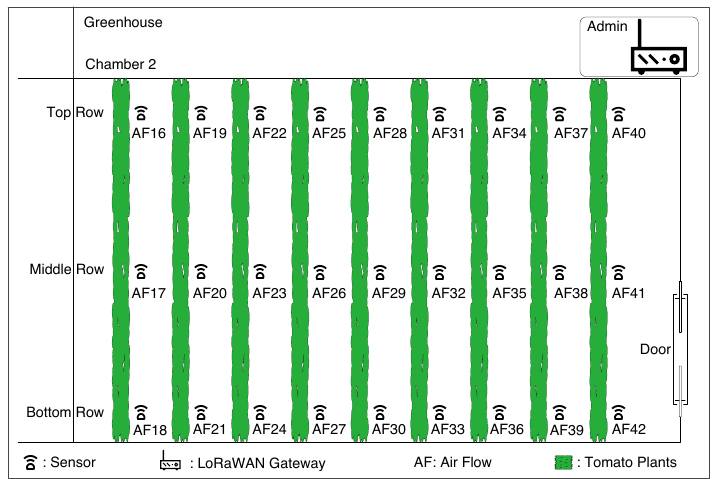
Figure 7. Visual representation of the chamber for growing tomato crop inside the greenhouse, along with the deployment location of sensor boxes, denoted as AF (air-flow) in each row of tomato plantation inside the